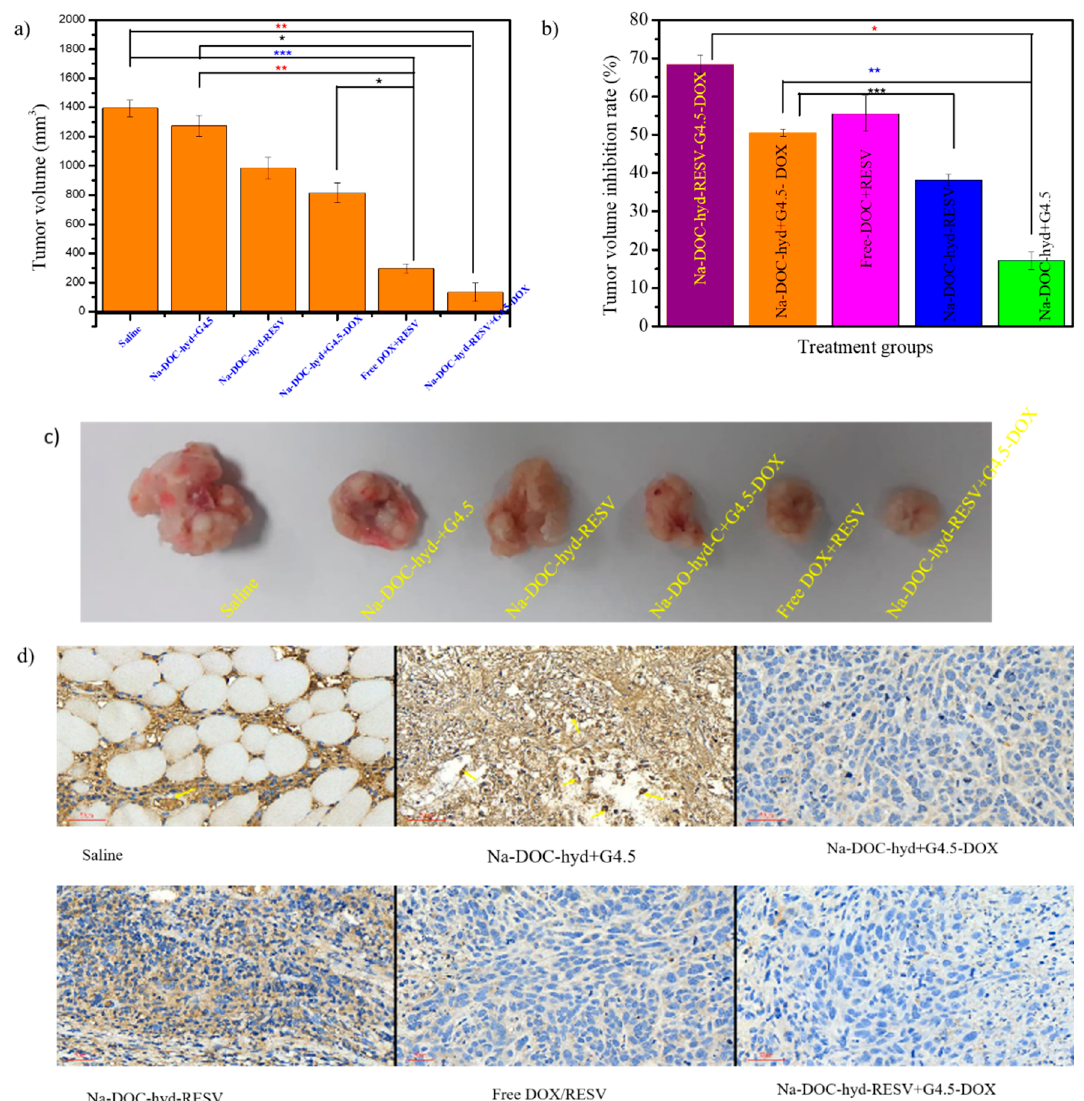
Figure 10. In vivo anti-tumor and ant angiogenic study in BALB/c nude mice inoculated with HeLa cells and treated with six different formulations. ( a ) Tumor volume, ( b ) the percentage of tumor volume inhibition rate (TVIR), ( c ) photograph of tumors samples collected from six different formulations treated mice groups, and ( d ) CD31-stained tumor tissue for estimating the micro-vessel density (MVD) (stained brown) after 28 days of treatment period (scale bar = 50 μ m, * p < 0.05, ** p < 0.005, *** p < 0.001; n = 4).